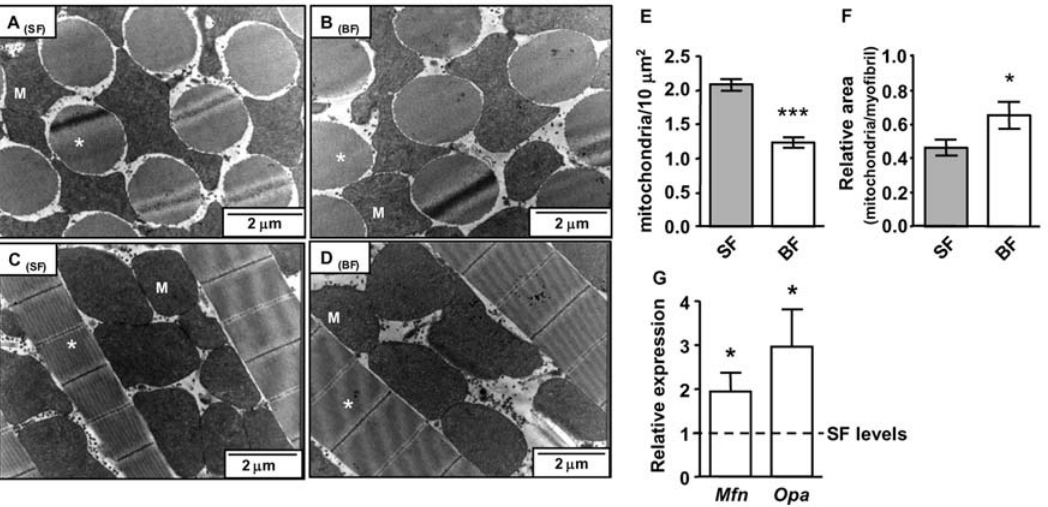
Figure 2. Mitochondrial fusion triggered by blood meal in A.aegypti FM. Transmission electron microscopy of transversal sections of A. aegypti FM fed on (A) sugar or (B) blood 24 h ABM showing the general architecture of myofibrils (asterisks) and the giant mitochondria (M). Longitudinal sections of A. aegypti FM fed on (C) sugar or (D) blood showing the myofibrils (asterisks) and the giant mitochondria (M). Scale bars represent 2 m m. (E) Mitochondrial density in sugar-fed (SF, grey bars) and 24 h ABM (BF, white bars) was calculated by dividing the number of organelles (SF, n=23 vs. BF, n=18; *** p , 0.0001) per 10 m m 2 . (F) Relative mitochondrial area in sugar-fed (SF, grey bars) and 24 h ABM (BF, white bars) was calculated by measuring absolute mitochondrial size and dividing by the absolute area of myofibrils (SF, n=61 vs. BF, n=41; * p , 0.05). (G) Expression of mitofusin ( Mfn ) and optic atrophy 1 ( OPA1 ) mRNA levels evaluated by qPCR in sugar-fed (dashed line) and 24 h ABM (white bars)(* p , 0.05). Bars represent mean 6 SEM and statistical analysis between groups was performed using Student’s t-test.